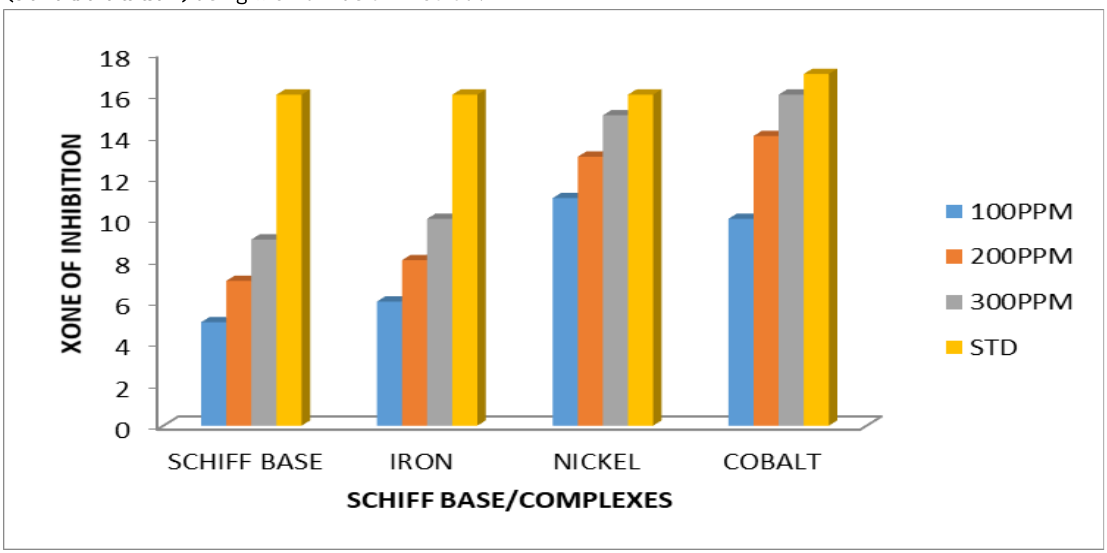
Figure 6. Sensitivity test for antifungal activity of Schiff base and its metal (II) complexes against clinical isolate ( Candida albican ) using well diffusion